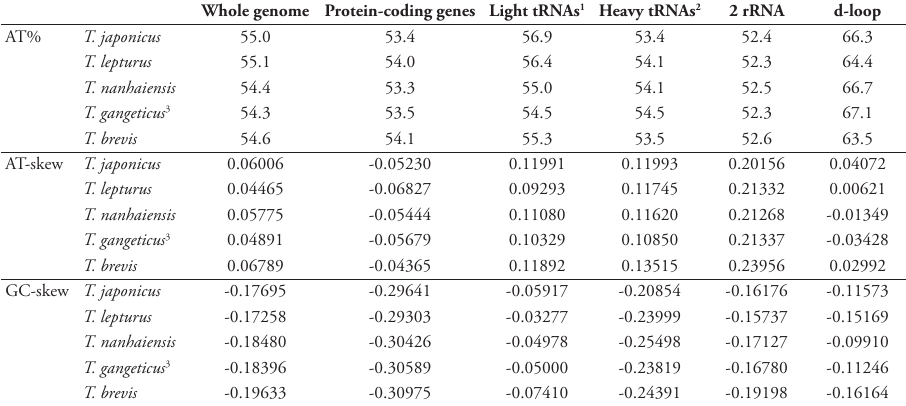
terial 1: Table S3. Overall codon usage among the sequenced Trichiurus mitogenomes was similar; Leu, Ala, Thr, Ile, and Ser were the five most common amino acids. The lengths of 16S rRNA genes ranged from 1.725 ( T. gangeticus ) to 1.742 ( T. lepturus ), whereas those of 12S rRNAs ranged from 957 ( T. gangeticus and T. nanhaien- sis ) to 959 ( T. brevius ). These rRNA genes are located between tRNA Phe and tRNA Leu and are separated by tRNA Val . The AT content of the rRNA genes ranged from 52.3% to 52.6% (Table 5). The total lengths of the 21 tRNA genes ranged from 1.483 ( T. Table 5. Nucleotide compositions of T. japonicus , T. lepturus , T. nanhaiensis , T. brevis , and T. gangeticus . Whole genome Protein-coding genes Light tRNAs 1 Heavy tRNAs 2 2 rRNA